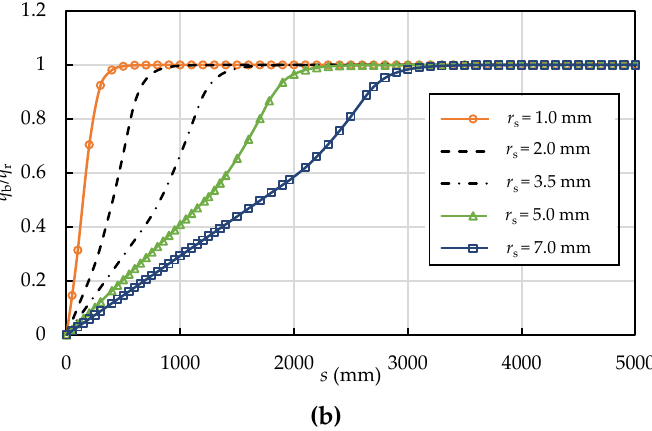
Figure 11. Effect of the size of the prestressing wire on the ( a ) interfacial shear and ( b ) normal stress distributions ( τ f = 1.8 MPa, δ 1 = 0.10 mm, k = 0.5, and δ f = 1.0 mm).